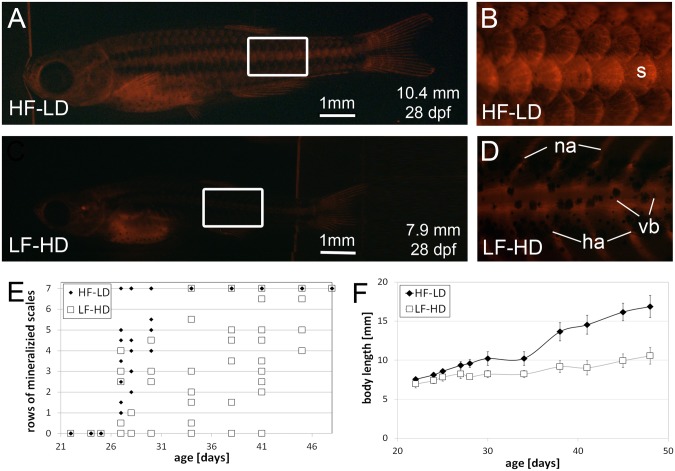
Hyperphagia results in increased linear growth and earlier scale formationA-D: Alizarin red staining of age-matched (28 dpf) juvenile fish (A,C) and corresponding magnification of the flank (B,D) of fish raised with high amounts of food at low density (A,B; HF-LD) and low amounts of food at high density (C,D; LF-HD). Body lengths of the shown individuals are indicated. Regions magnified in (B,D) are boxed in (A,C). E: Graph summarizing scale mineralization status (number of rows of mineralized scales) of analyzed fish at different ages. HF-LD fish started to display 7 rows of mineralized from an age of 27 days onwards, while it took LF-HD fish at least 34 days to reach this stage. F: Body length growth curves of sibling fish as in (A-E) shown as mean +/- standard deviation of 10 analyzed fish per condition and time point. LF-HD fish are significantly shorter than HF-LD fish. Similar results were obtained in a second, independent experiment. Abbreviations: ha, hemal arch; dpf, days post-fertilization; na, neural arch; s, scale; vb, vertebral body.